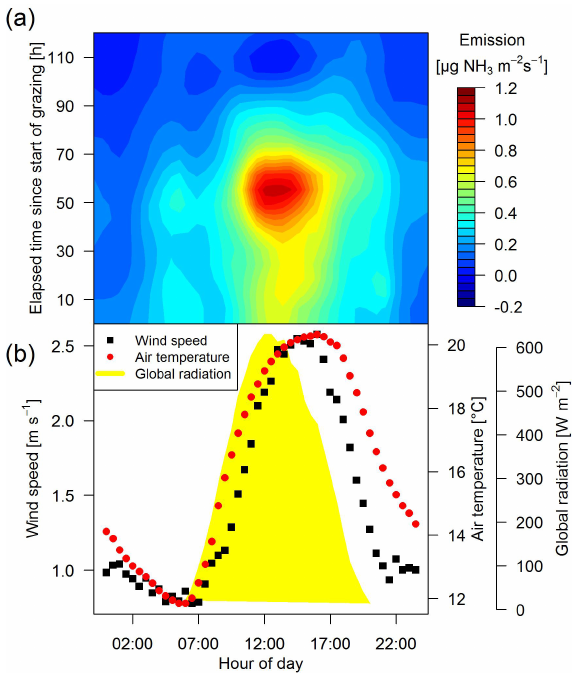
Figure 5. (a) Measured averaged half-hourly fluxes of all rotations for system M depending on hour of day and elapsed time since graz- ing on the paddocks between MD2 and MD5 started. (b) Half-hourly averaged values of global radiation, wind speed and air temperature measured at system M during May to October 2016.